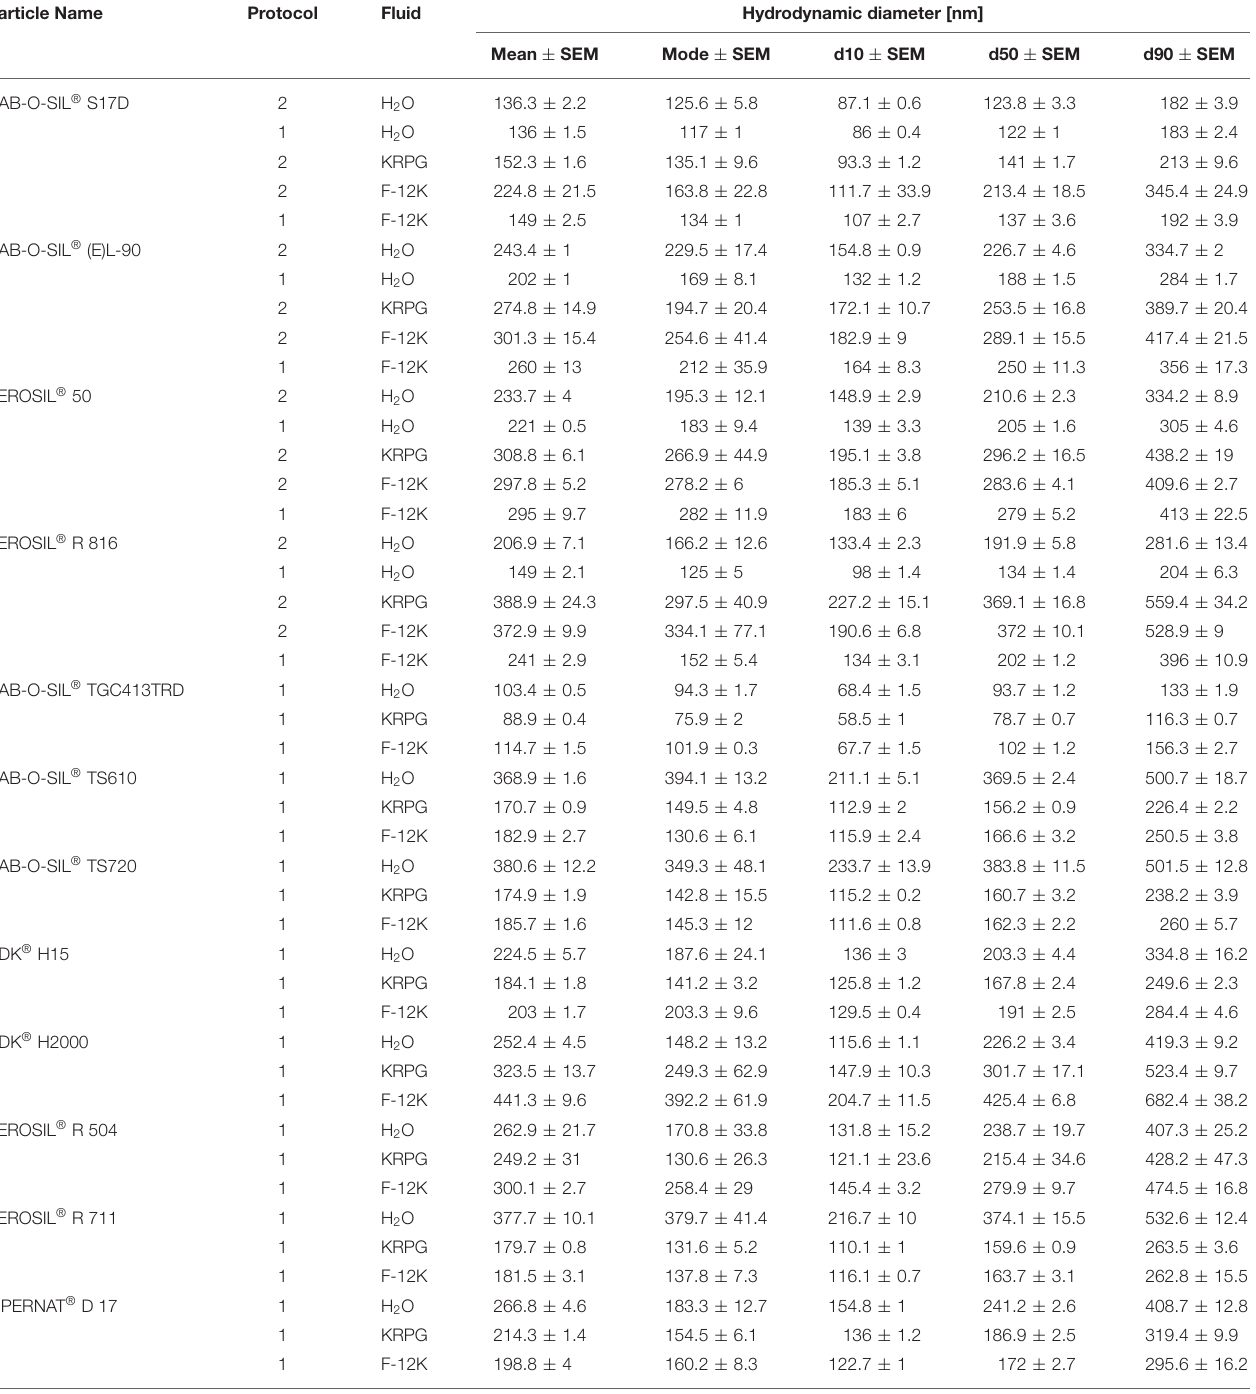
TABLE 2 | Hydrodynamic diameter of SAS particles in H 2 O, KRPG buffer, and F-12K